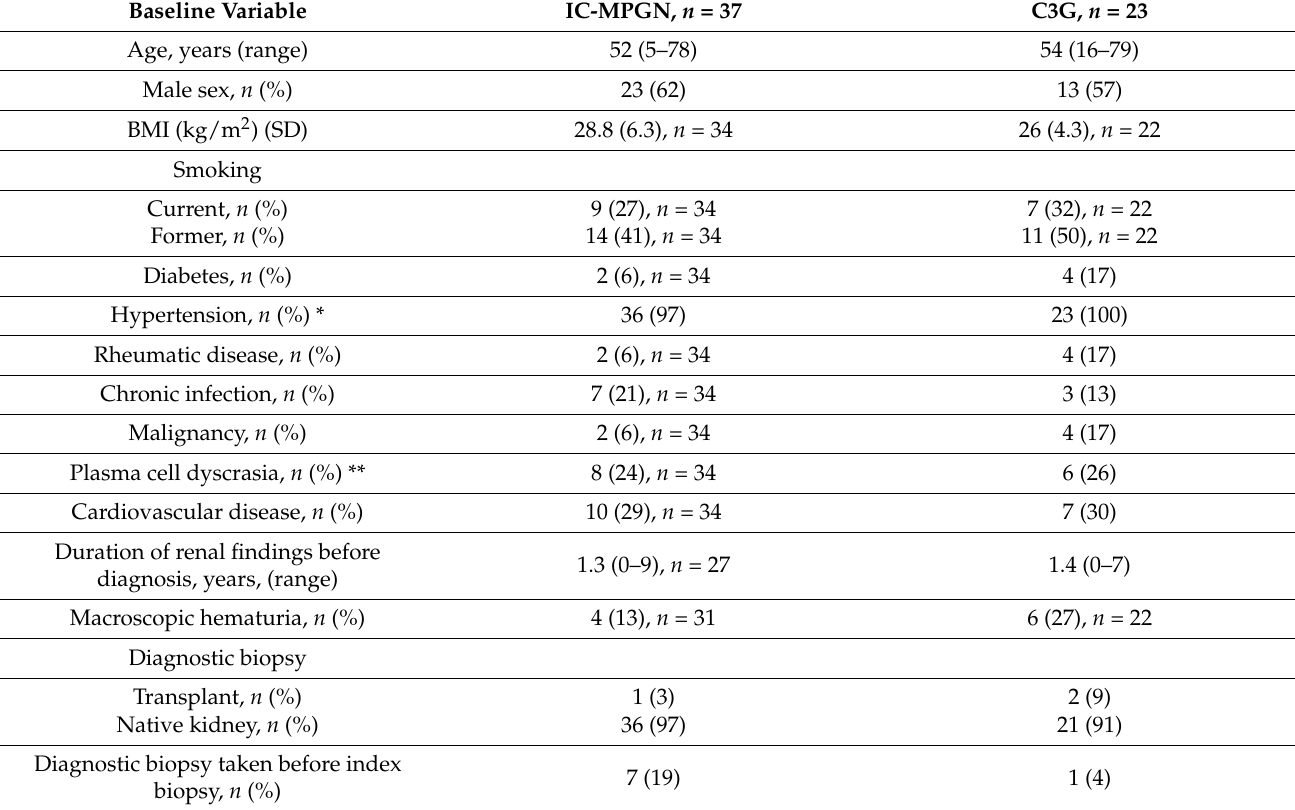
Table 1. Patient characteristics at baseline. Values are expressed as means (range or SD) or numbers (percentage) of patients. Reference values and units are given where appropriate. The number of patients indicates the maximum number of patients available with the information. Unless otherwise indicated, the parameter values were available for all patients. The differences between the groups were not significant ( p > 0.05 for all